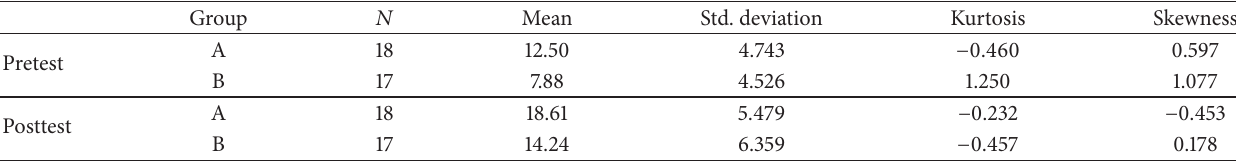
Table 1: Scores of groups A and B in the pretest and posttest.